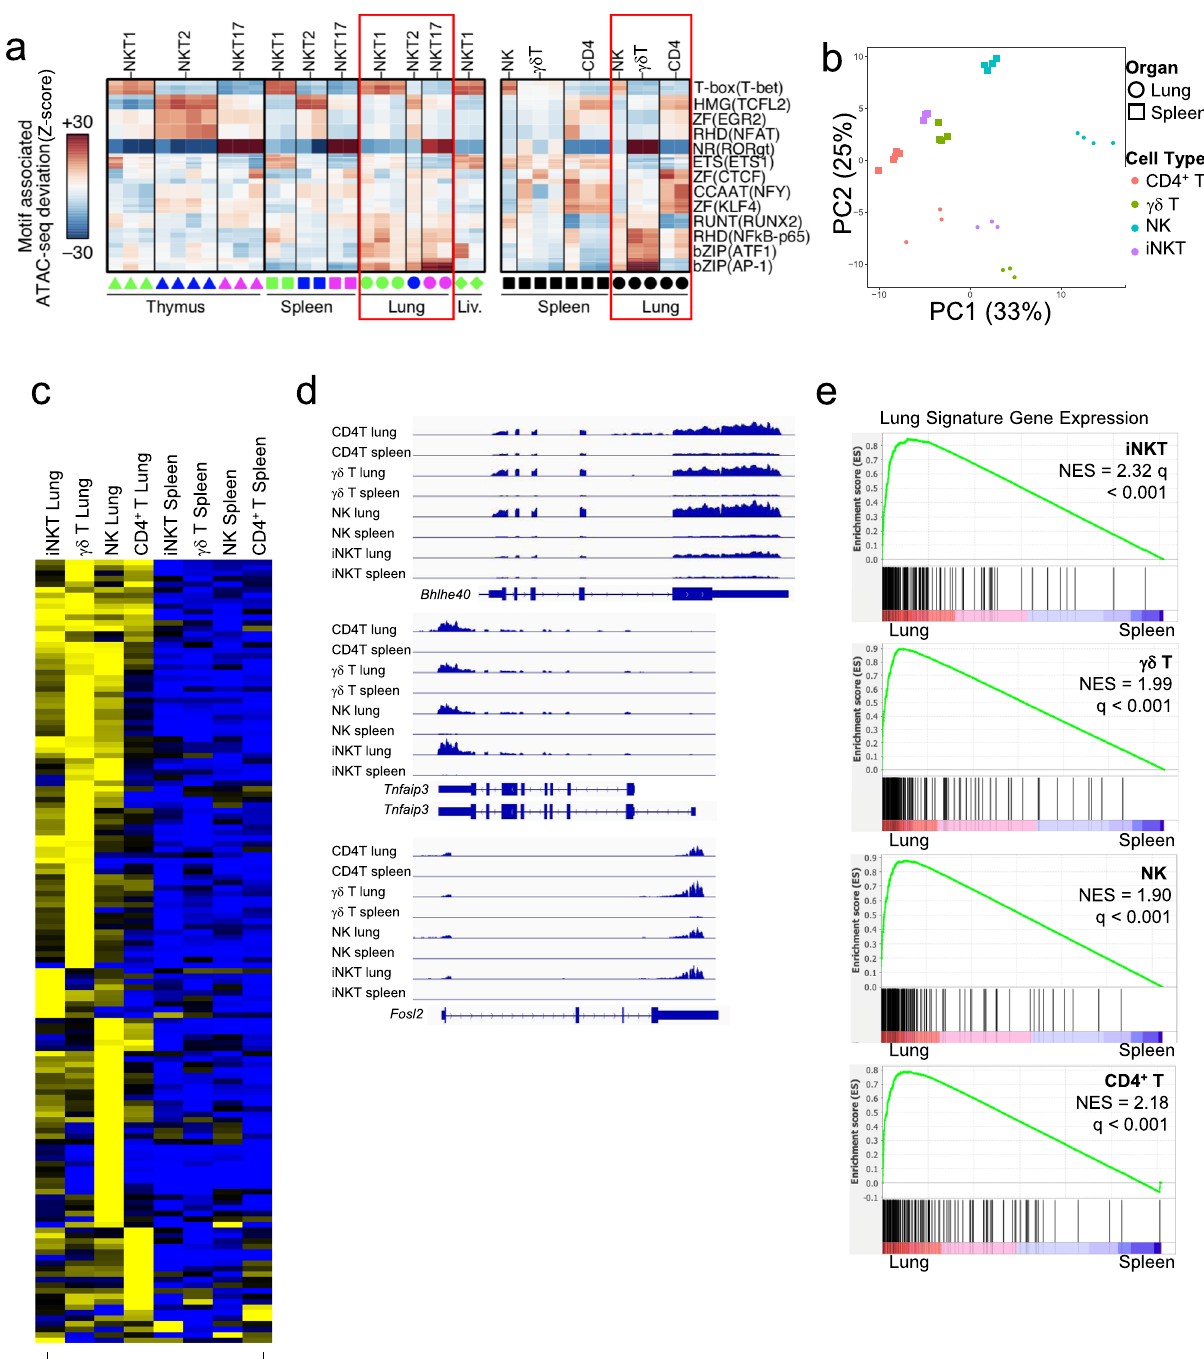
Fig. 4 Lung signature extends to other lung populations. a chromVAR computed deviation in ATAC-seq signal (Z-score) at regions containing indicated transcription factor motifs between the indicated cell populations from spleen and lung. Motifs with a p value less than 1e-25 are shown and families and representative members are labeled. Tissue source of the samples indicated at the bottom of the diagram; columns indicate number of replicates. b PCA of RNA-seq data comparing lymphoid cell types isolated from lung and spleen. c Heat map depicting the lung gene signature from Supplementary Fig. 3 with normalized transcript levels from RNA-seq data from the indicated cell types from lung and spleen. d RNAseq read tracks in the Bhlhe40 , Tnfaip3 , and Fosl2 loci in samples from lung and spleen from indicated cell types. e GSEA of pre-ranked comparisons of genes differentially expressed in lung iNKT cell subsets comparing each cell type within the lung to its counterpart in the